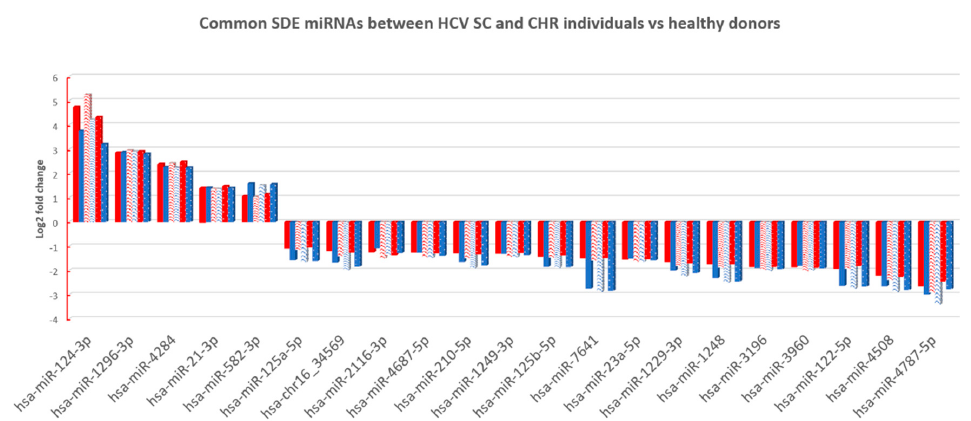
Figure 4. The log2 fold change (FC) of SDE 21 miRNAs between CHC patients (columns in red) and SC individual’s (columns in blue) vs. HC for each method of analysis (columns with different patterns). Similar log2FC were identified in all cases. J. Clin. Med. 2019 , 8 , x FOR PEER REVIEW